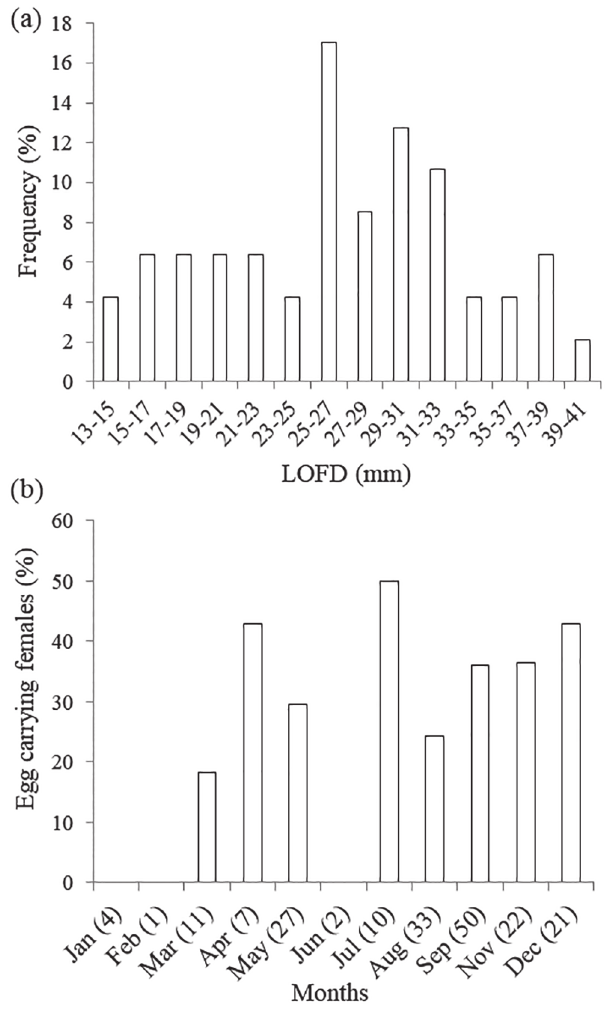
Fig. 7 . a. Frequency distribution of the largest ovarian follicles diameter (LOFD) in mature females of Atlantoraja cyclophora . b. Seasonal variation in the proportion of egg- carrying females of A. cyclophora . The number of samples analyzed is between parentheses.